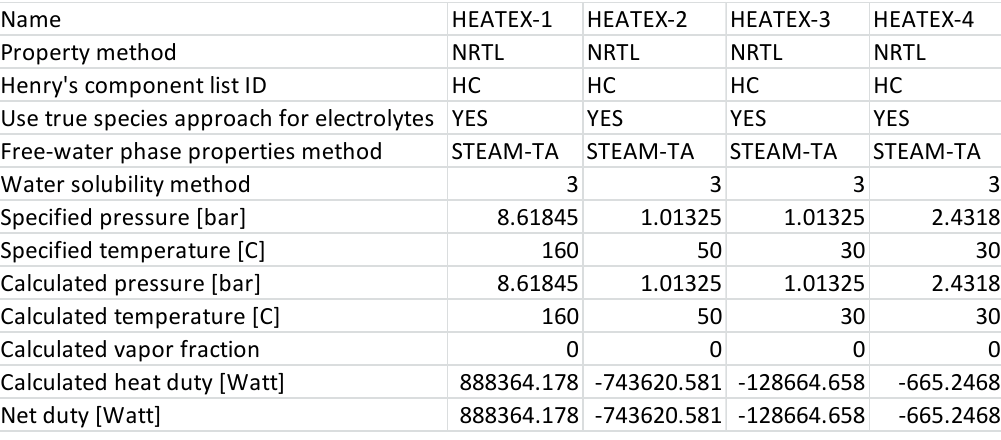
Figure A13. Fermentation pump results.